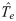
Tb is the crab body temperature, S is the surface temperature, B is the burrow temperature, and Te^ is the operative body temperature when burrows offer no thermal refuge (B = S).The x-coordinate of the linear regression of Tb − S vs. S (red point) provides an initial estimate for Treg. A more precise Treg is found by finding the surface temperature where Tb-S=Te^-S (blue point) and then adding Te^-S to get the corresponding crab body temperature.